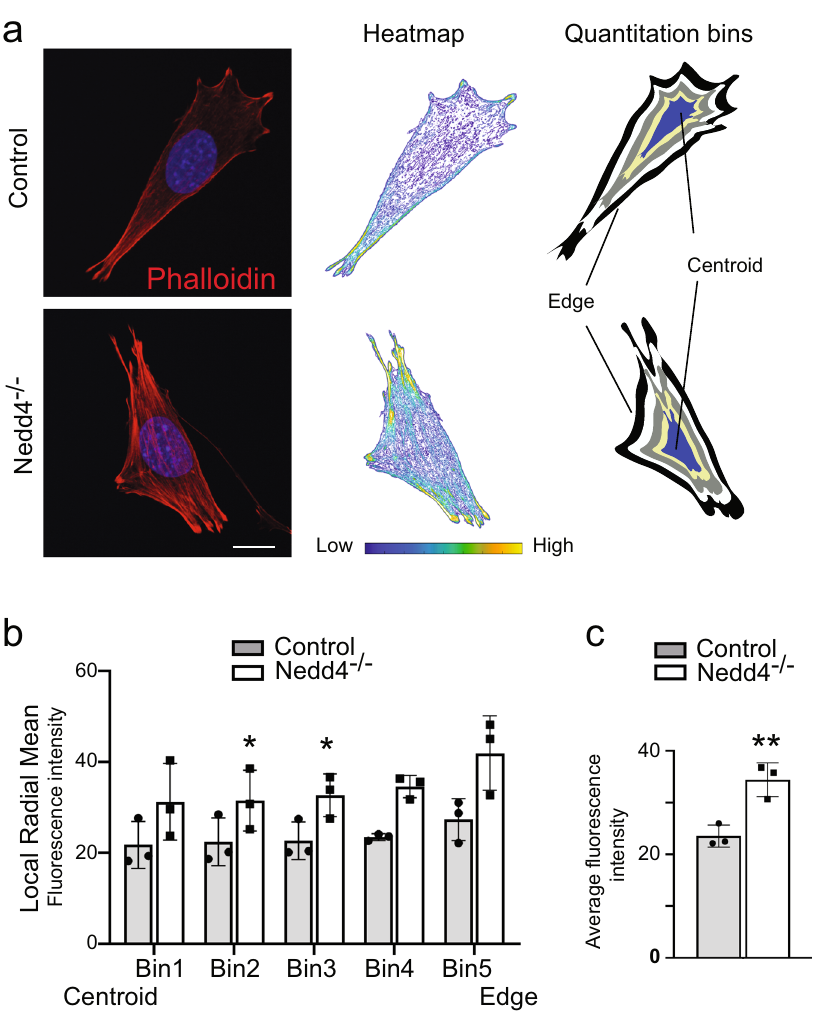
Fig. 5 Quantitation of fi lamentous actin in Nedd4 − / − NCCs. a F-actin was stained in WT and Nedd4 − / − NCCs with fl uorescently conjugated phalloidin (red). Pseudocoloured heatmaps of actin intensity were used to measure actin levels by obtaining the Radial Mean Intensity in 5 separate bins from the centre to the edge. Images are representative of 10 individual cells per genotype. b Quantitation of actin levels in each of the bins from WT and Nedd4 − / − NCCs. Data are presented as mean + / − SEM. * P = 0.049 for Bin 3, P = 0.0016 for Bin 4, P = 0.054 for Bin 5 as determined by type two Student ’ s t test. c Quantitation of average F-actin levels in WT and Nedd4 − / − NCCs. n = 3 biologically independent replicates. Scale bar = 10 μ m. Data are presented as mean + / − SEM. ** P = 0.008 as determined by type two Student ’ s t test. Source data are provided as a Source data fi